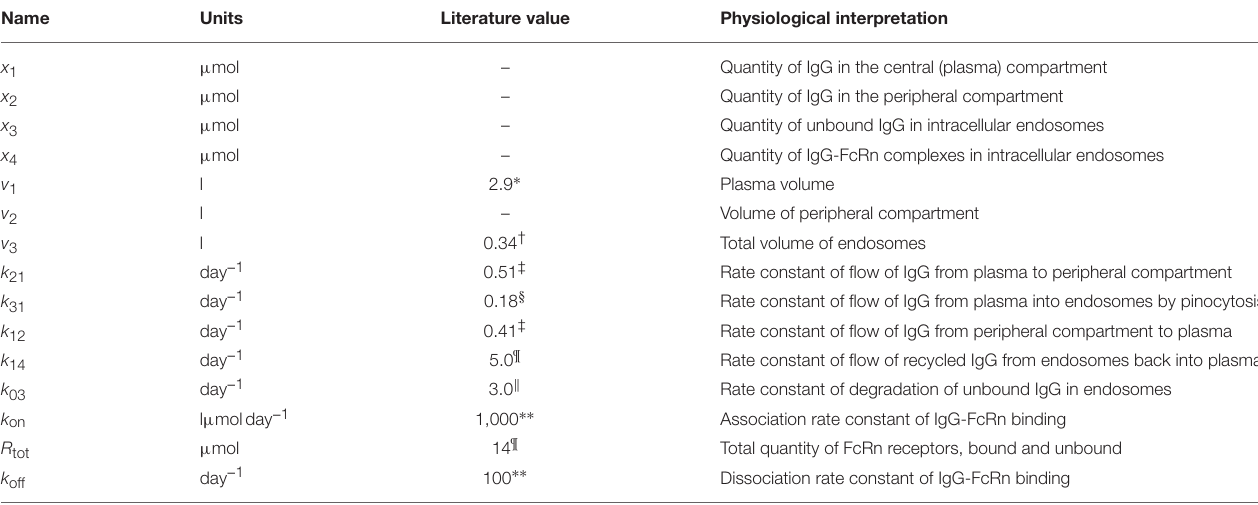
TABLE 1 | States and parameters of four-compartment model of IgG metabolism, with parameter values sourced in the literature.